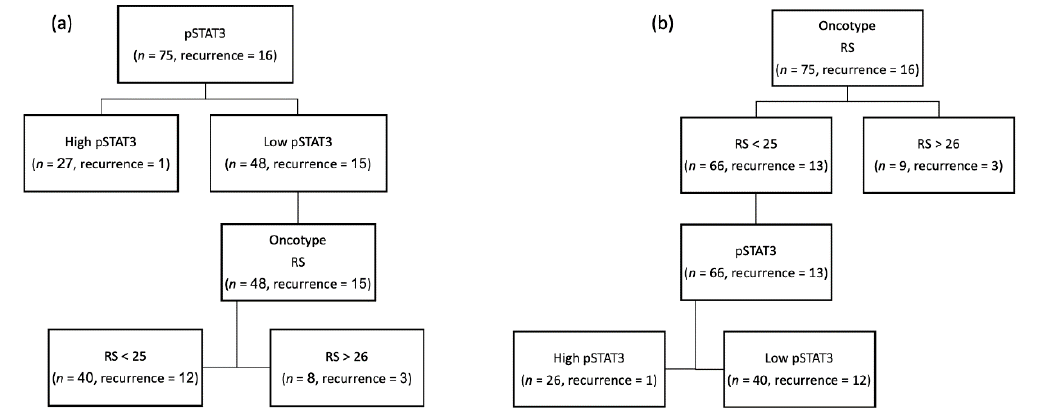
Figure 2. ( a ) Patients divided according to their pSTAT3 IHC scores; ( b ) patient allocation started according to RS scores.